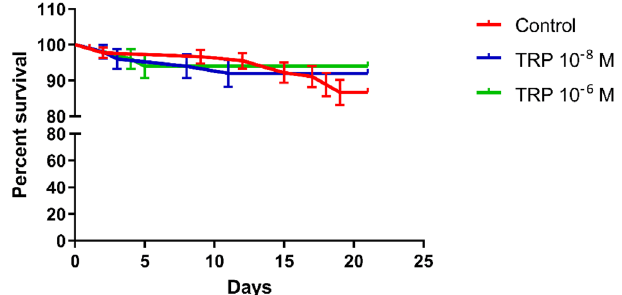
Figure 1. Survival curve of T. molitor males after the injection of physiological saline (control) and Tenmo- TRP-7 at concentrations of 10 –7 and 10 –5 M (final concentrations in insect bodies of 10 –8 and 10 –6 M, respectively). The values are given as the means ±